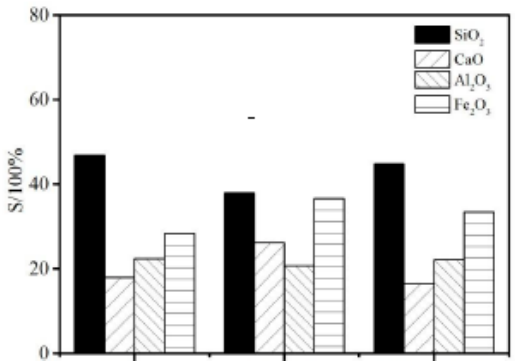
Figure 6. Stripping rate among four di ff erent oxides and three di ff erent asphalts [34].